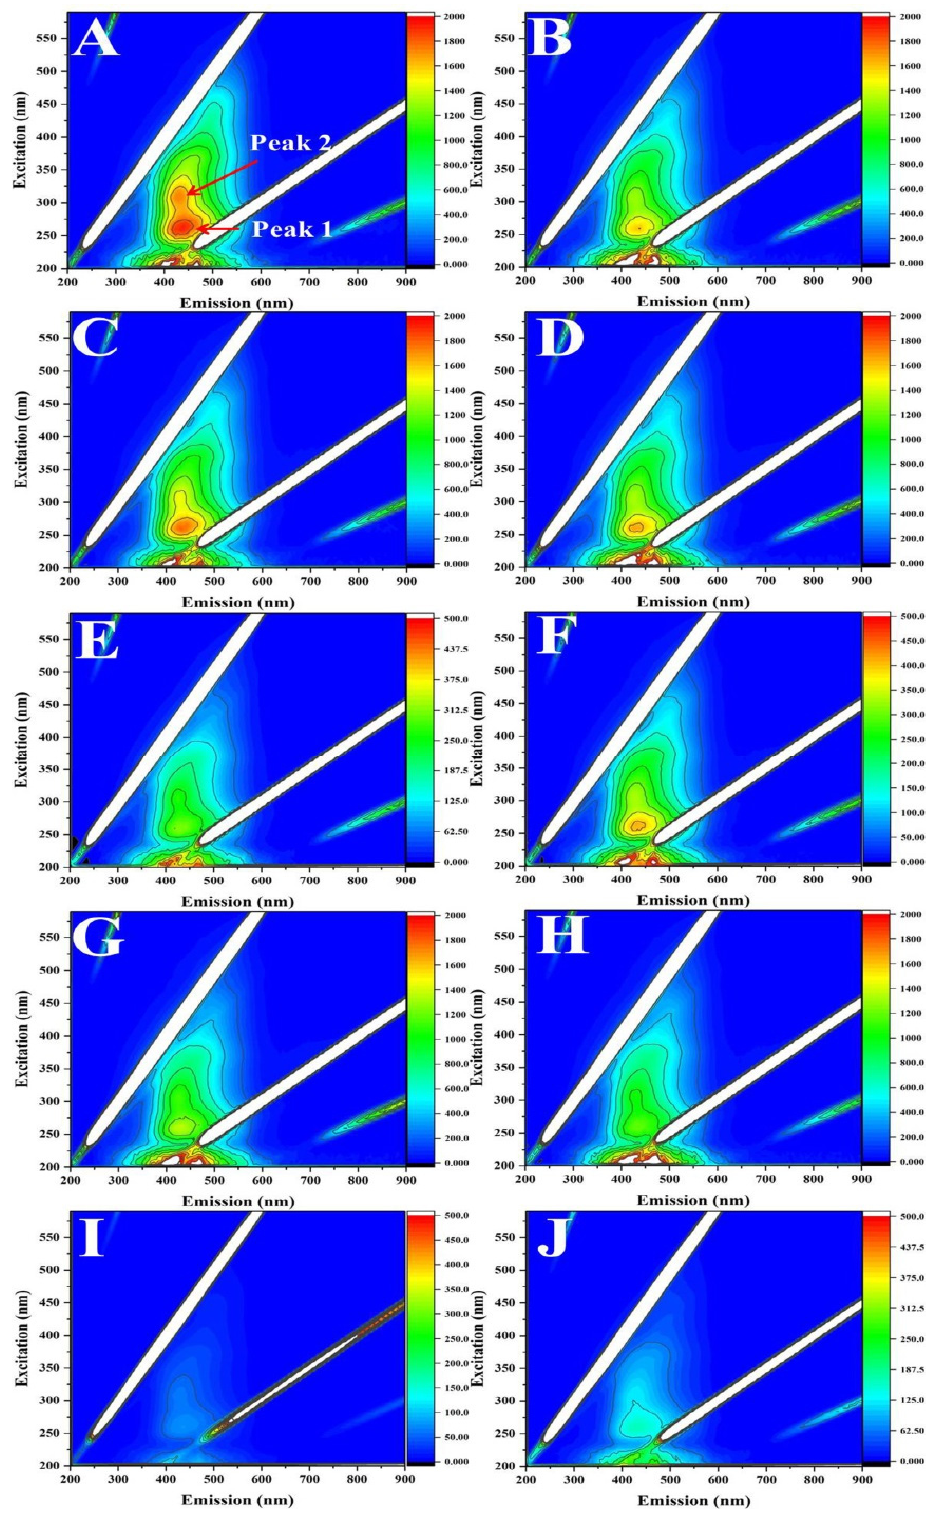
Figure 4. Fluorescence EEM spectra of HA and HA aggregates after long aggregation time due to the addition of Cs + or Co 2+ metal ion: ( A ) HA—pH 5.0; ( B ) HA—pH 7.0; ( C ) Cs + = 3.0 mmol/L, pH = 5.0; ( D ) Cs + = 5.0 mmol/L, pH = 7.0; ( E ) Cs + = 14.0 mmol/L, pH = 5.0; ( F ) Cs + = 25.0 mmol/L, pH = 7.0; ( G ) Co 2+ = 0.03 mmol/L, pH = 5.0; ( H ) Co 2+ = 0.10 mmol/L, pH = 7.0; ( I ): Co 2+ = 1.3 mmol/L, pH =5.0; ( J ) Co 2+ = 0.90 mmol/L, pH = 7.0; HA = 50 mg/L.